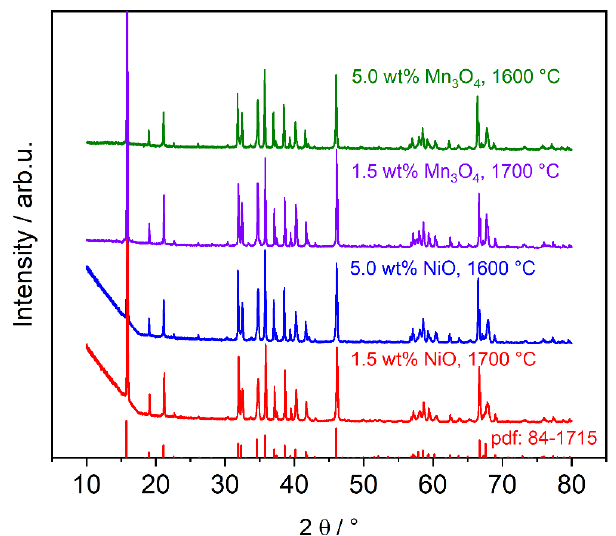
Figure 5. Diffraction patterns of Mn 3 O 4 - and NiO-doped Na- β″ -alumina. The reflex 006 (15.9°) is clipped off. The literature reflexes of Na- β″ -alumina (pdf 84-1715) are illustrated by the red bars at the